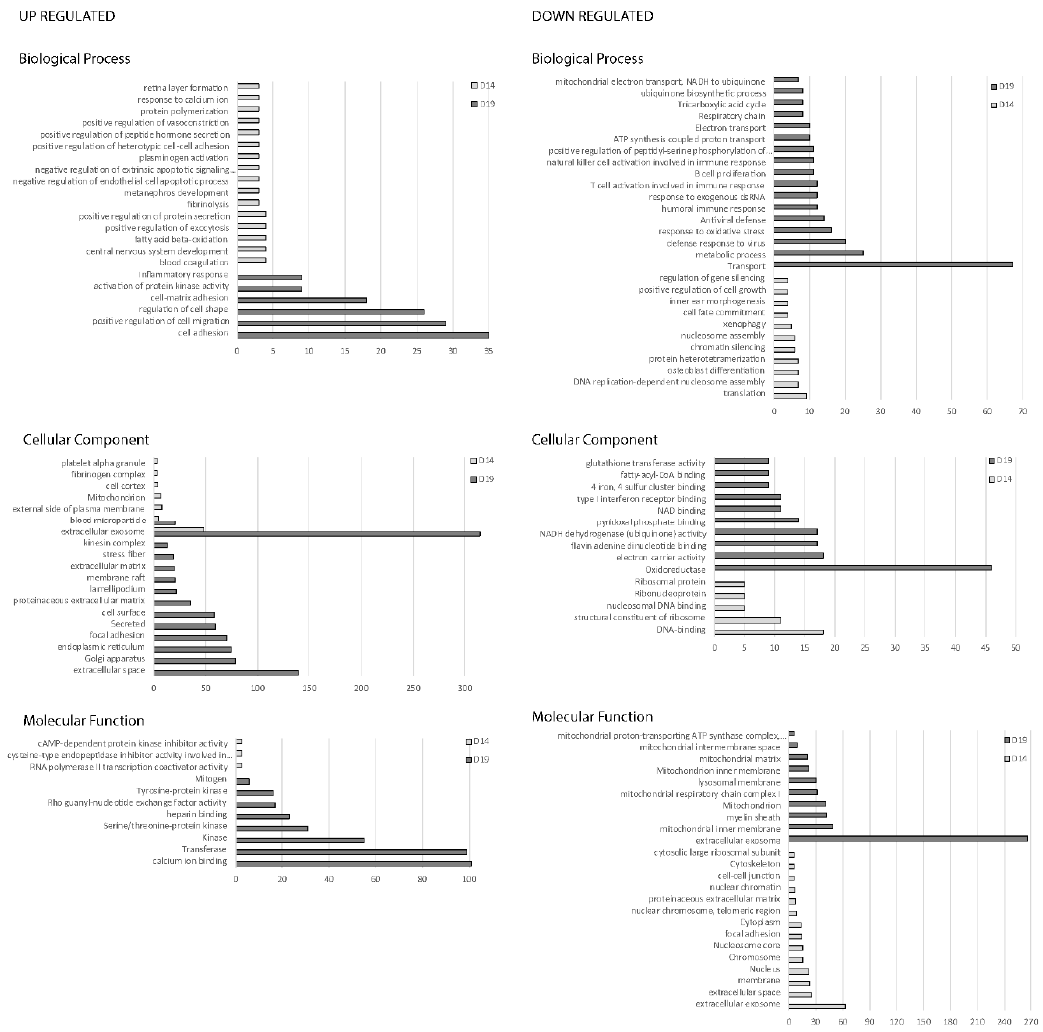
Figure 6. Gene ontology analysis for genes upregulated and downregulated in equine conceptus membrane, on day 14 and 19 of pregnancy between synchronous (recipient and donor ovulated on same day) and asynchronous (recipient ovulated 5 days after the donor) ET (D14 Syn / Asyn and D19 Syn / Asyn). The major categories within the biological process, cellular component and molecular function are represented by the number of genes involved in the category, selected on the basis of a p -value < 0.05.